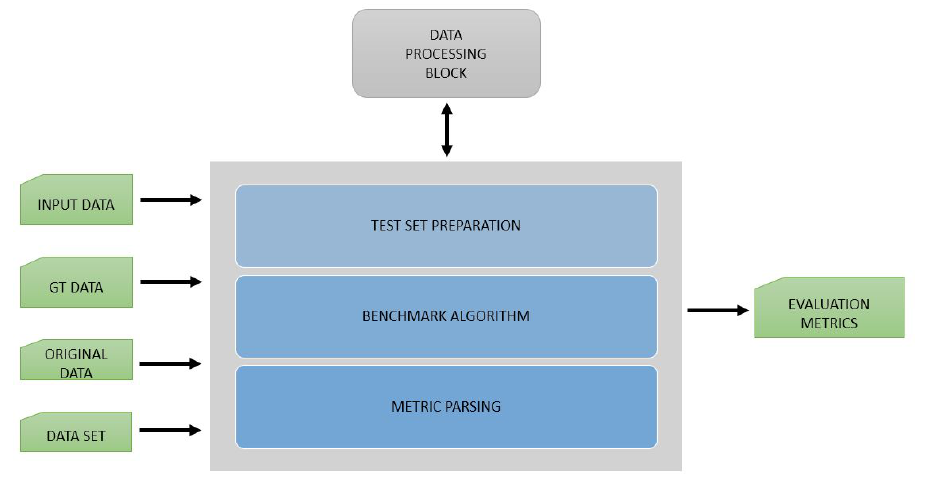
Figure 9. EECVF benchmark block